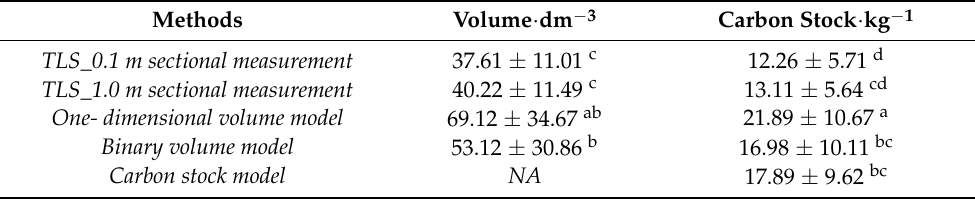
Table 1. Comparison of volume and trunk carbon stocks measured via the different methods assessed. Each value represents the sample mean ± standard deviation, and different lowercase letters indicate significant differences between timber volumes measured in different segment lengths ( p <